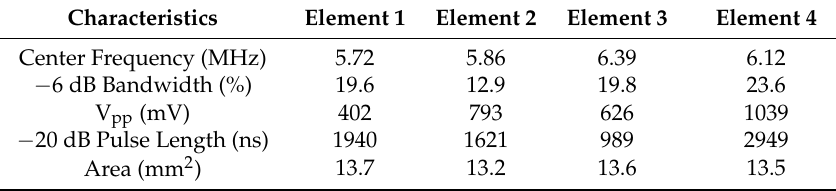
Table 1. The measured pulse and echo characteristics for all